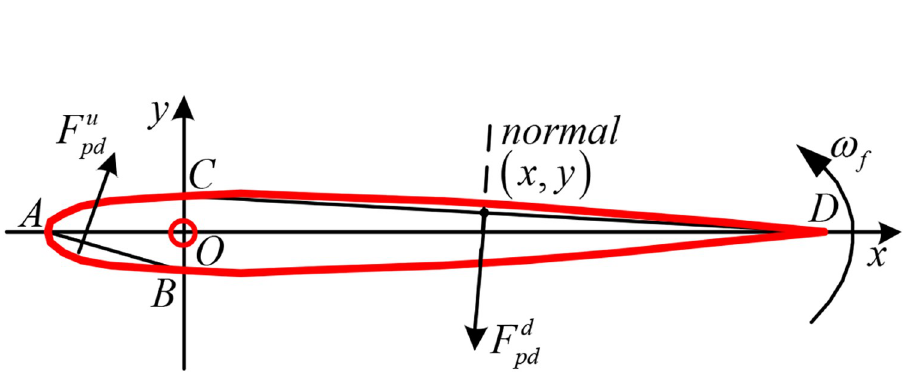
Fig 2. Diagram of the pressure drag